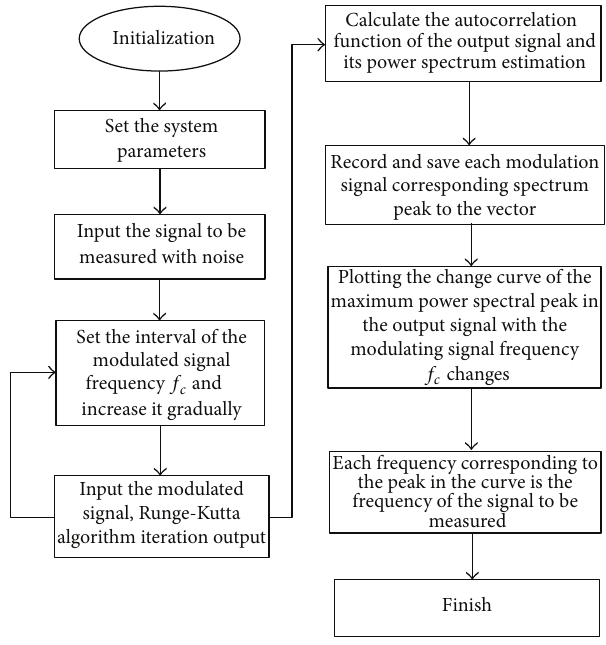
Figure 10: The flow